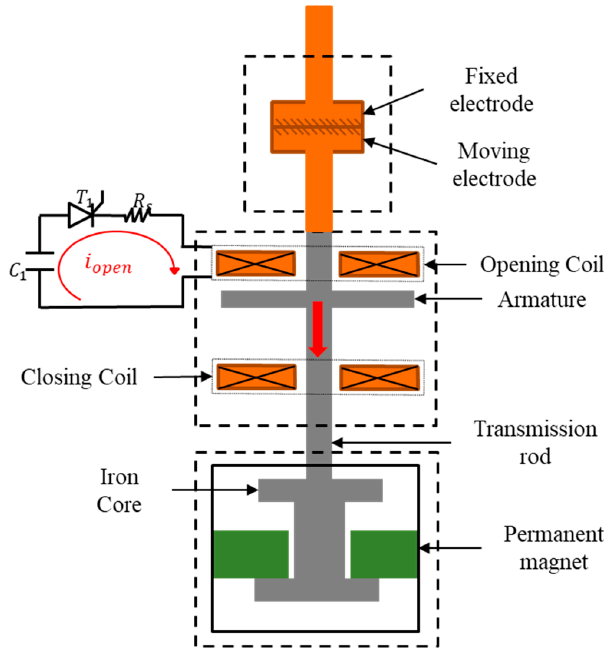
Figure 9. TCA utilizing permanent magnet (PM) holding mechanism, redrawn as depicted in [60]. Table 2. Different holding mechanisms’ performance in the literature.